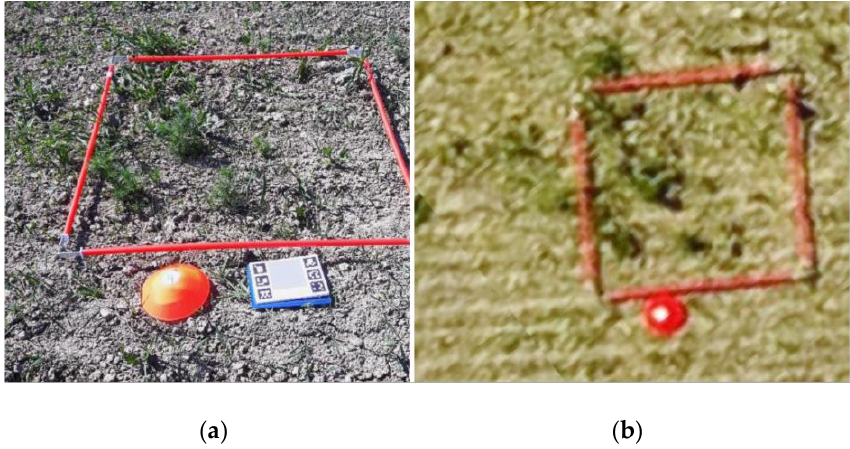
Figure 4. Reference square (1 m × 1 m) for weed observations at our test site in 2019: ( a ) a close-up photo of the square, number, and reflectance calibration target; ( b ) the same square in the orthophoto calculated from drone images showing same weeds (the calibration target was located near landing area in the ortophoto).